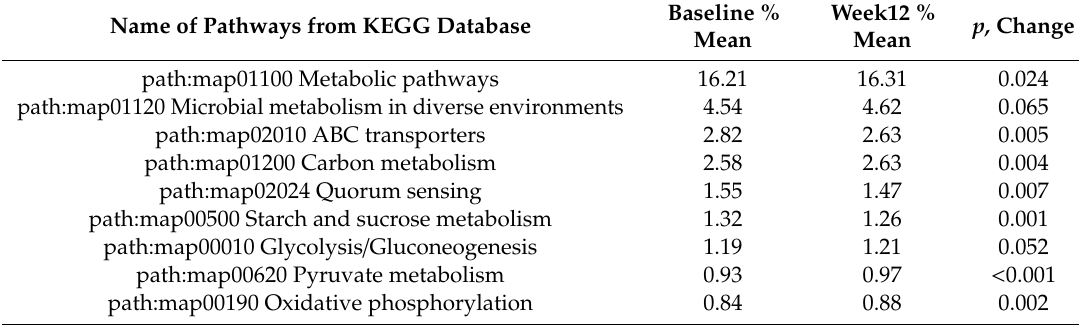
Table 8. Piphillin functional interpretation from 16S